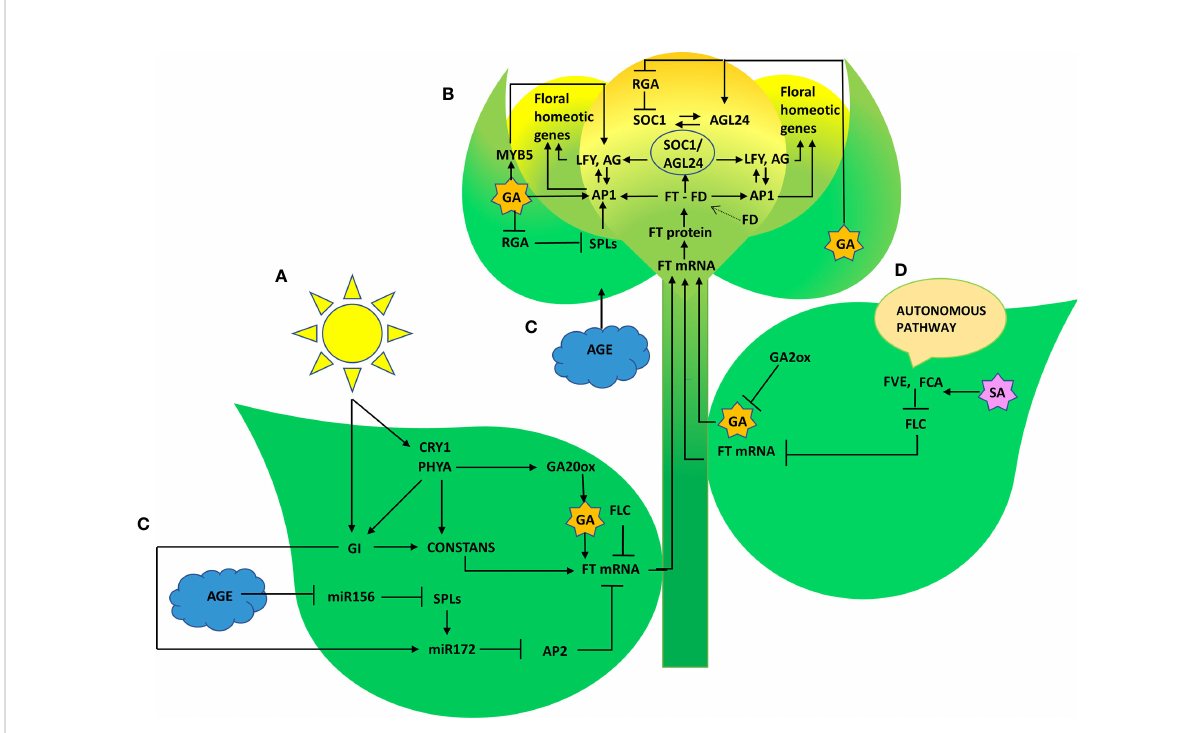
FIGURE 8 Graphical summary of key regulatory pathways triggered by P. indica that induced fl oral transition in P. nigrum L. (A) Photoperiod pathway (B) Gibberellin biosynthesis pathway (C) Age pathway (D) Autonomous